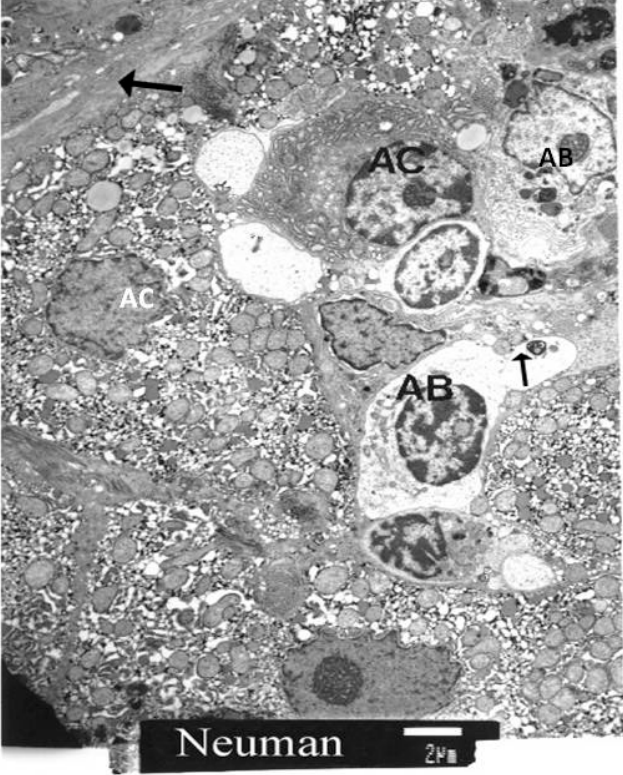
Figure 5. TEM of a biopsy. A shrunken apoptotic cell with a shrunken chromogen nucleus is at the bottom of the micrograph. Other apoptotic cells are scattered in the micrograph. Apoptotic bodies (AB) can be observed. The arrow points to fragments of cellular debris.